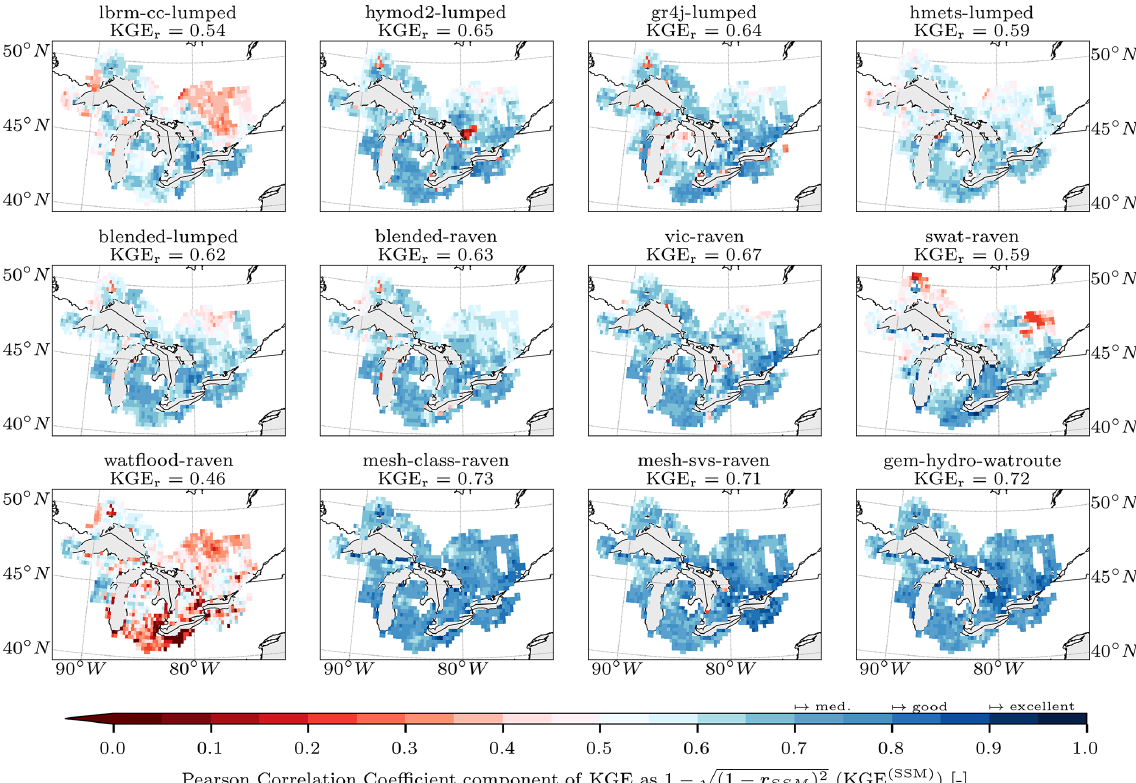
Figure 6. Grid-cell-based model performance regarding surface soil moisture. The performance of 12 models (panels) regarding surface soil moisture (SSM) is shown. The model outputs are regridded to the grid of the reference dataset (here GLEAM v3.5b; variable SMsurf ). Only grid cells that are available in the reference dataset and all 12 models are displayed (1213 grid cells in total) and used to derive the Pearson correlation coefficients (KGE r ) based on all available summer month observations (June to October) between 2001 and 2017. The median KGE r across space is added as a label at the top of each panel. The color bar has labels added to categorize the performance into medium, good, and excellent. The machine-learning-based LSTM model is not displayed, as this is the only model not simulating surface soil moisture explicitly. Note that only VIC-Raven, SWAT-Raven, MESH-CLASS-Raven, MESH-SVS-Raven, and GEM-Hydro simulate (surface) soil moisture explicitly, while the remaining models used proxy variables for soil moisture. All SSM estimates were standardized to account for the proxy nature of the variables (Eq. 5) and, hence, only the correlation coefficients (KGE r ) are reported